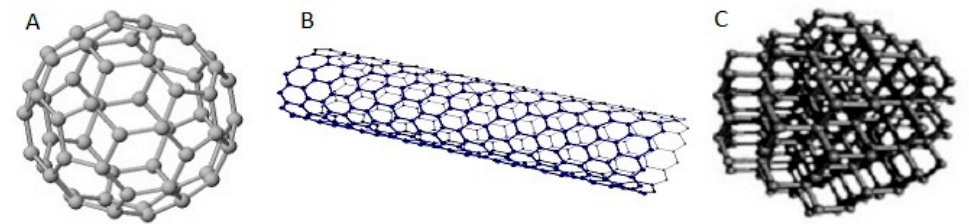
Figure 1. Structures of ( A ): C 60 fullerene (http://chemia.waw.pl/fulereny.htm accessed on 13 June 2021); ( B ): carbon nanotube (http://www.fizyka.iss.com.pl/nanorurki/08rysunki05.html); ( C ): nanodiamond [10].